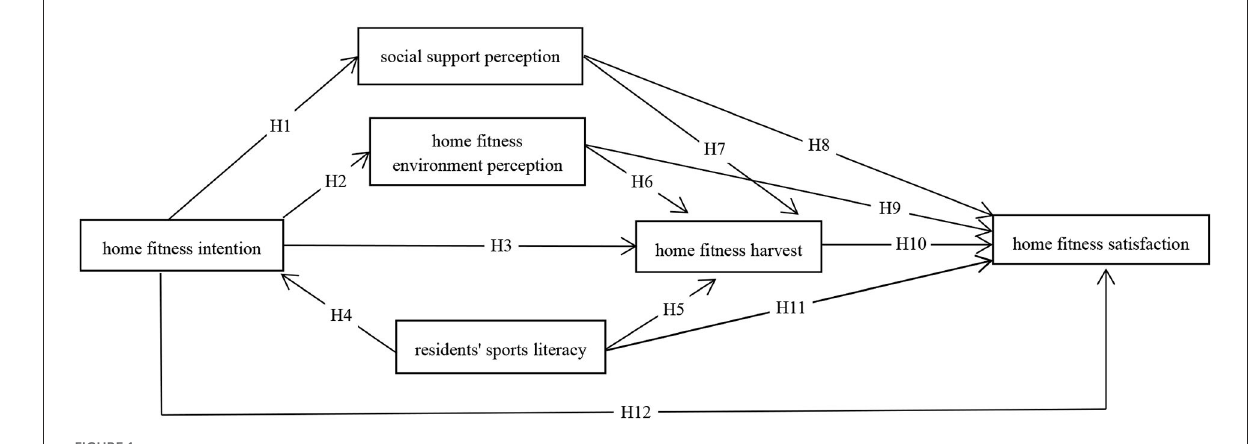
FIGURE1 Conceptual model of residents’ satisfaction with home fitness during the epidemic